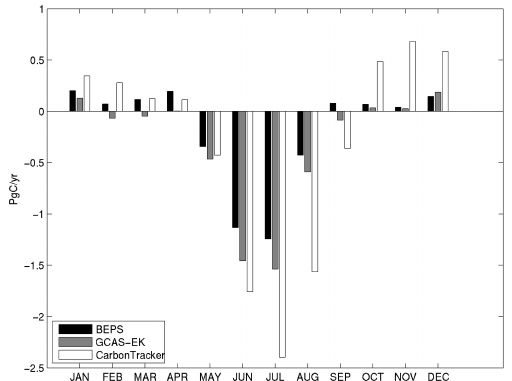
Figure 10. Comparison of multiyear average monthly variations from 2002 to 2008 by three products: BEPS, GCAS-EK and Car- bonTracker 2011.